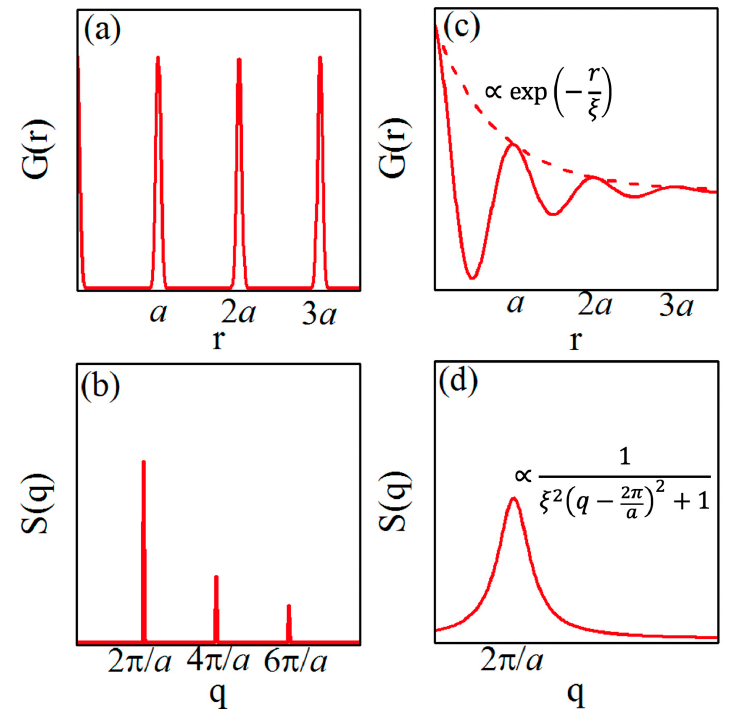
Figure 1. Schematic representation of the correlation function G ( r ) in real space and the structure factor S ( q ) in reciprocal space for one-dimensional systems with long-range order ( a , b ) and short-range order ( c,d ). Due to the exponential decay of the envelope of the correlation function in